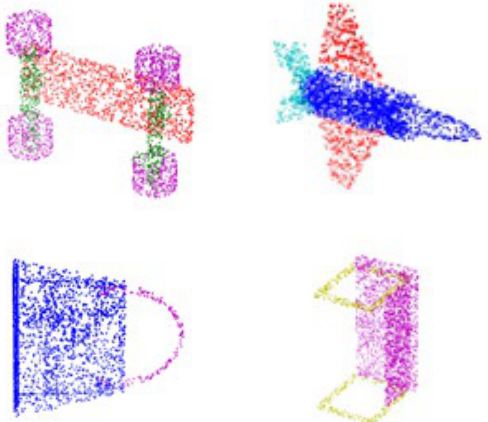
Figure 3. Several part segmentation results obtained by AP-GCN.